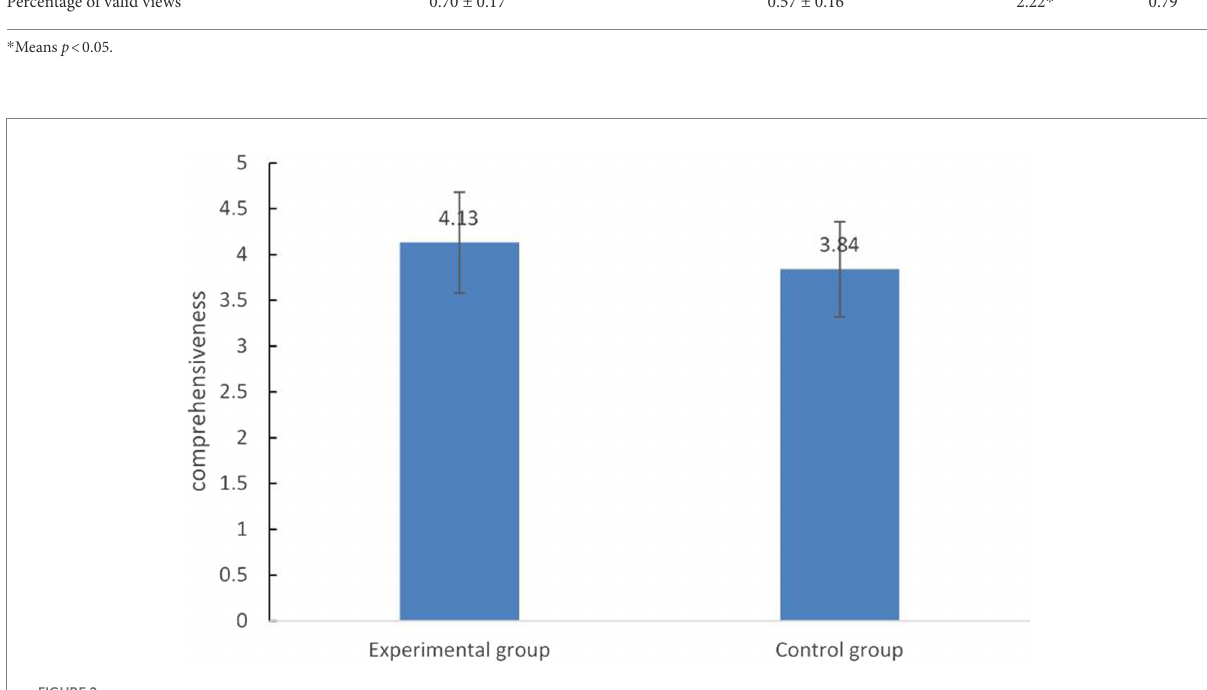
FIGURE 2 Comparison of the self-reported discussion effectiveness between the two